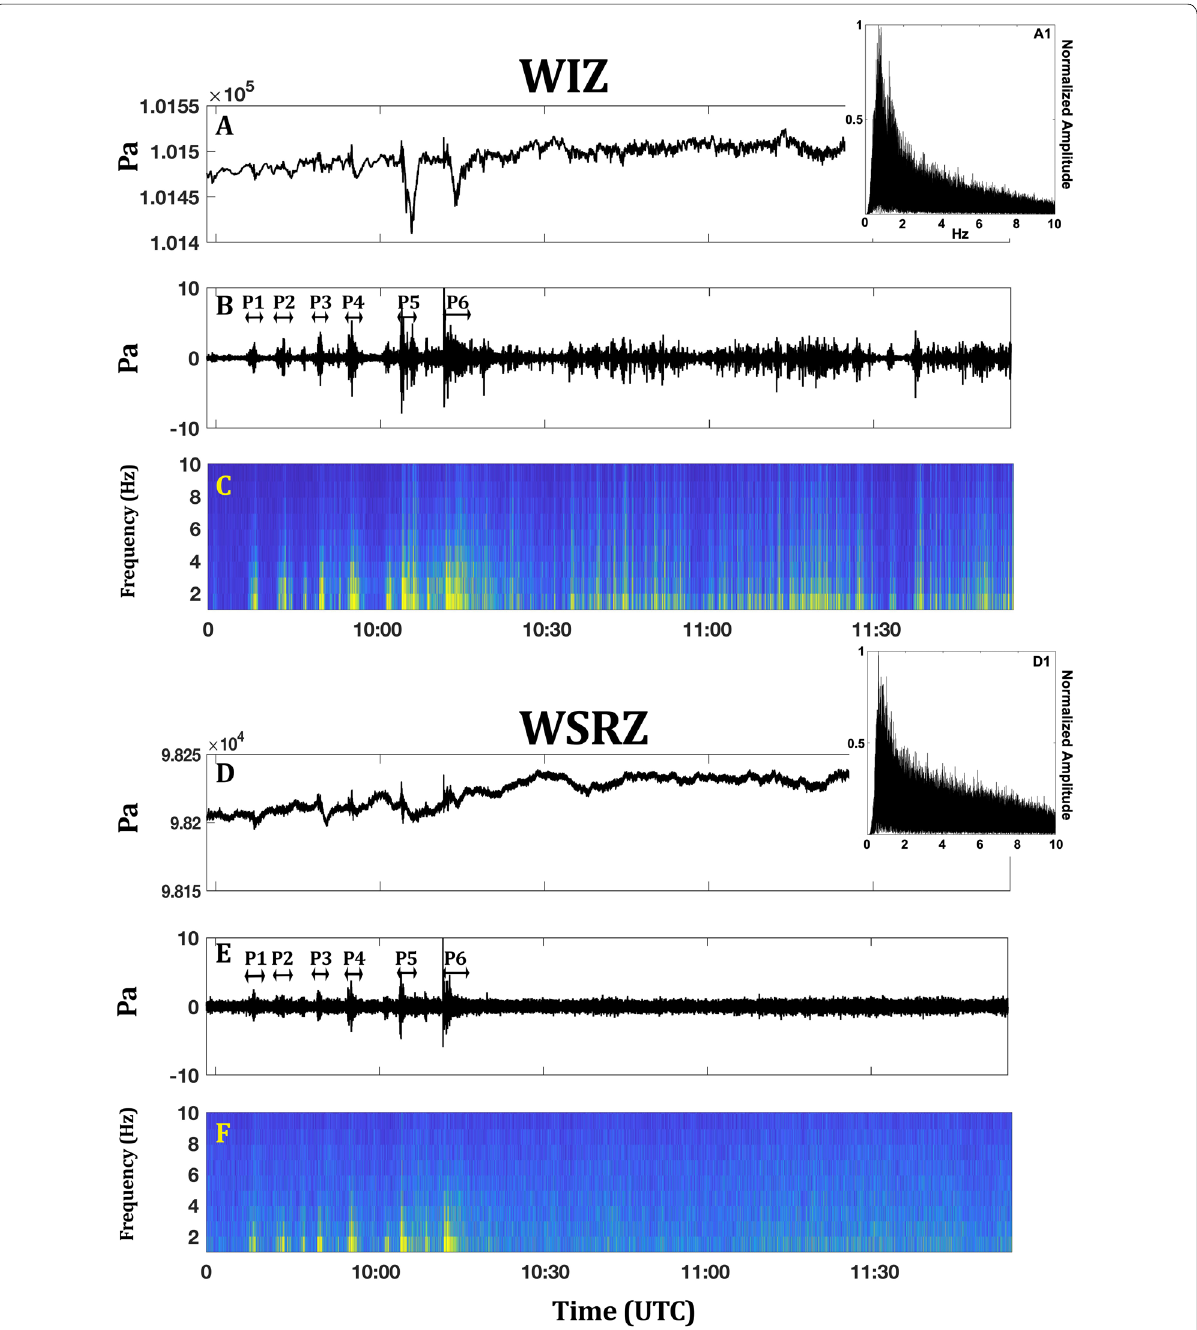
Fig. 3 Acoustic waveform data for both acoustic stations for the 27 April 2016 eruption on Whakaari. A Non-filtered raw sensor reading for WIZ showing the increasingly larger down pressures from the rarefaction of the eruption pulses as the acoustic wave passes the station. B Filtered acoustic data between 0.5 and 10 Hz, C spectrogram for WIZ, D non-filtered raw sensor reading for WSRZ, E filtered acoustic data between 0.5 and 10 Hz for WSRZ, F eruption spectrogram for WSRZ. A1 and D1 are the spectra for WIZ and WSRZ